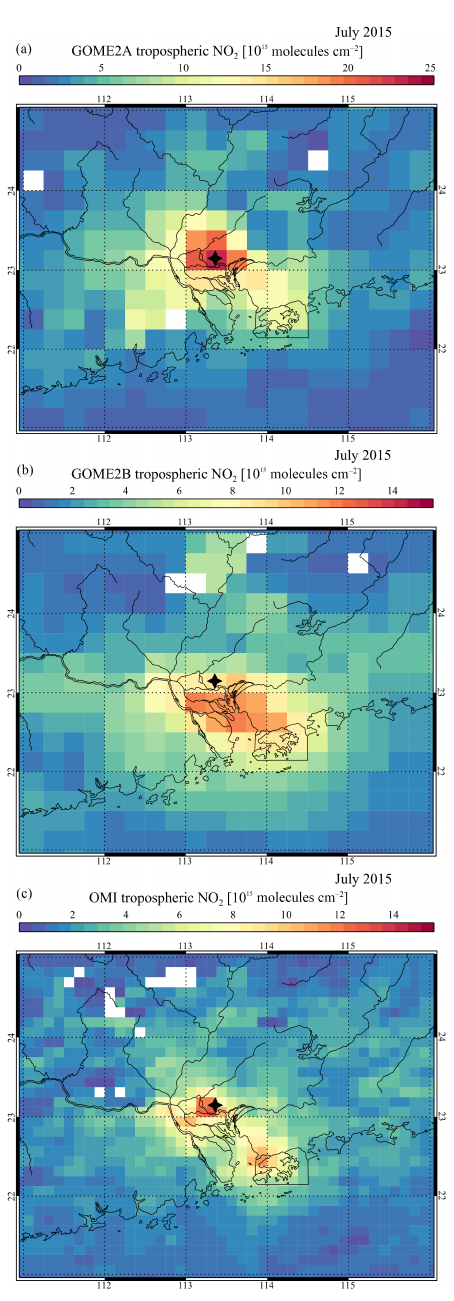
Figure 5. Monthly averages of GOME-2A, GOME-2B and OMI NO 2 tropospheric VCDs for July 2015 are presented. The GOME- 2A monthly tropospheric NO 2 mean values (on a 0.25 × 0.25 ◦ grid) are shown in (a) , the GOME-2B, also on a 0.25 × 0.25 ◦ grid, in (b) and OMI/Aura on a finer, 0.125 × 0.125 ◦ , grid in (c) . The star sym- bol shows the MAX-DOAS location. The NO 2 observations aver- aged and gridded here correspond to cloud radiance fraction <50%. Note that the color bars have different